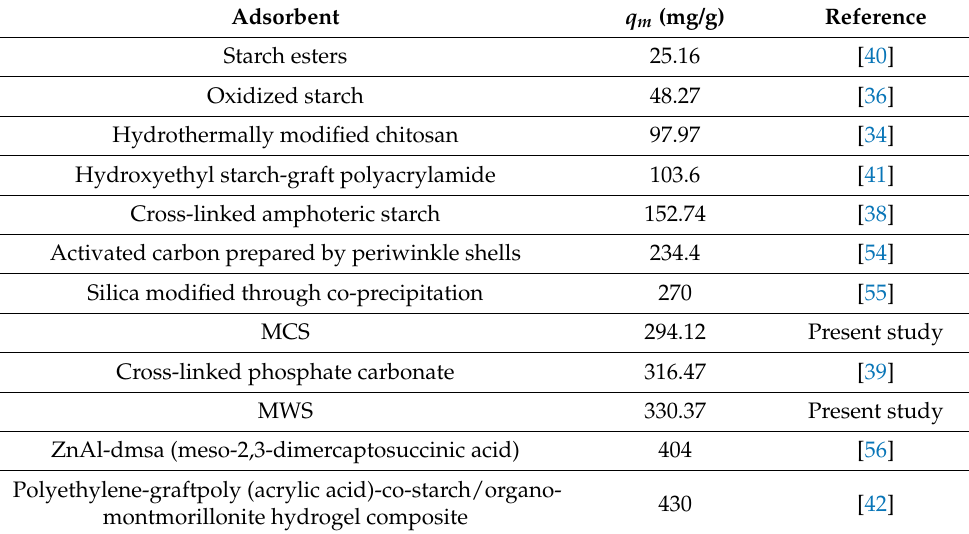
Table 8. Comparison of the Pb(II) ions adsorption capacities of various adsorbents.